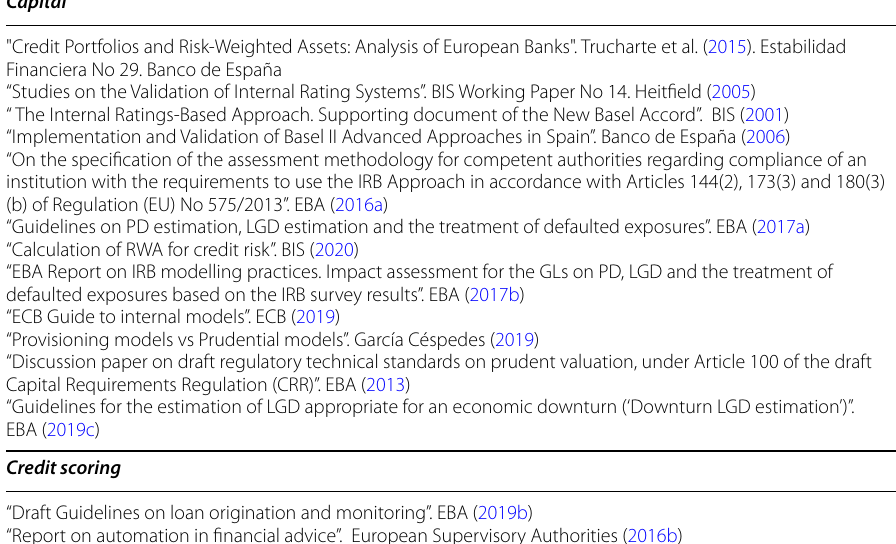
Table 12 Set of regulatory texts analysed, classified by purpose of the model